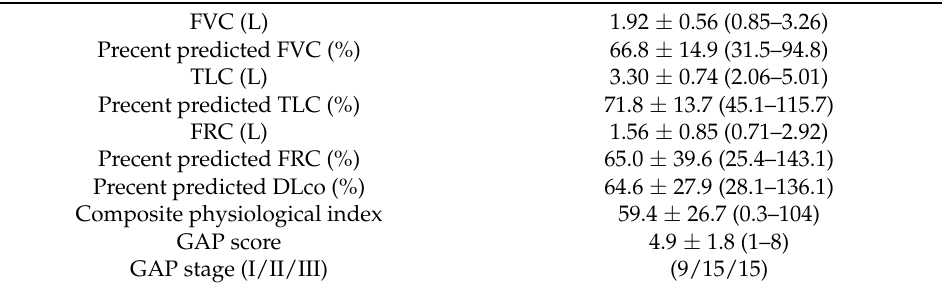
Table 2. Physiological data of IPF patients ( n = 39).